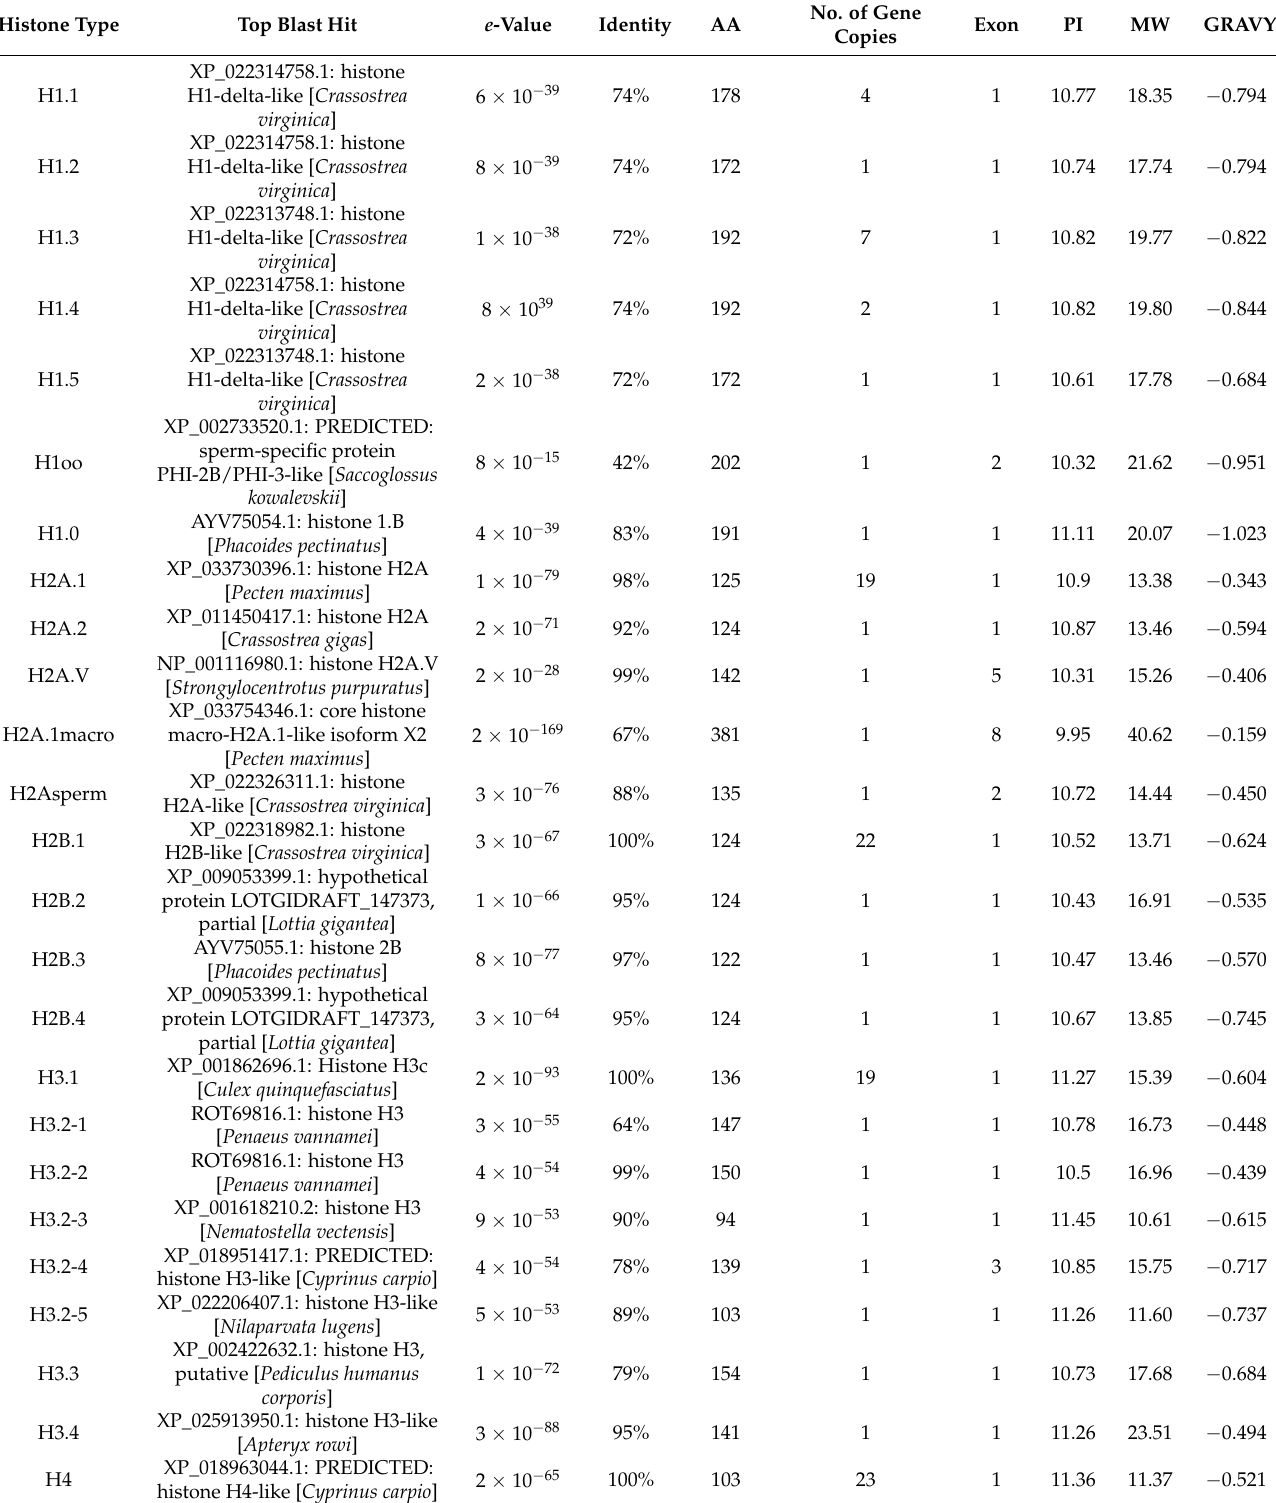
Table 2. Types of S. constricta